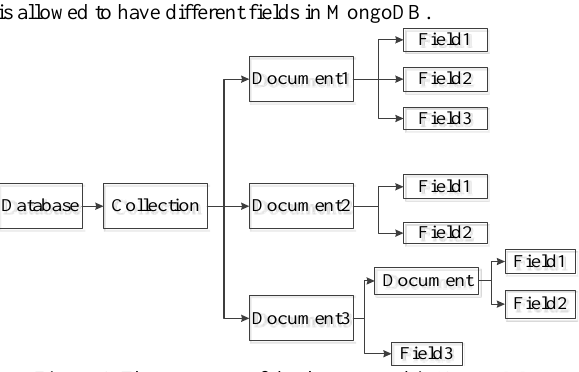
Figure 4. The structure of database stored in